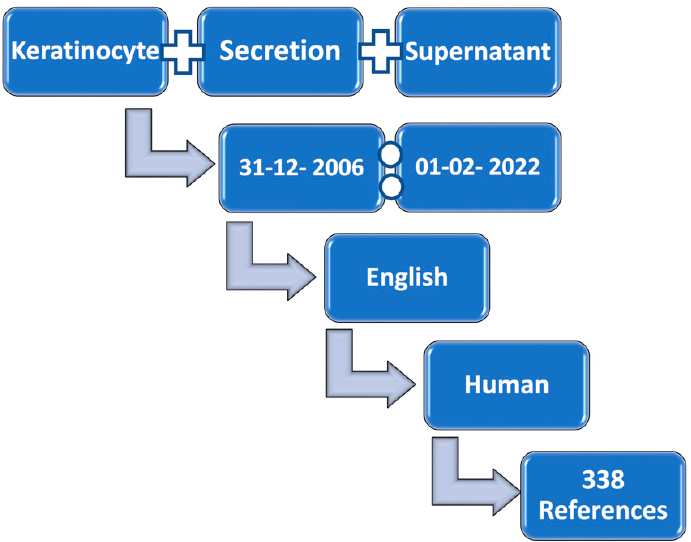
Figure 1. Flow chart of the online search strategy used in this study.